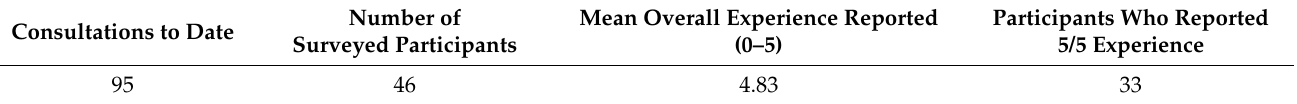
Table 3. LWABC survey